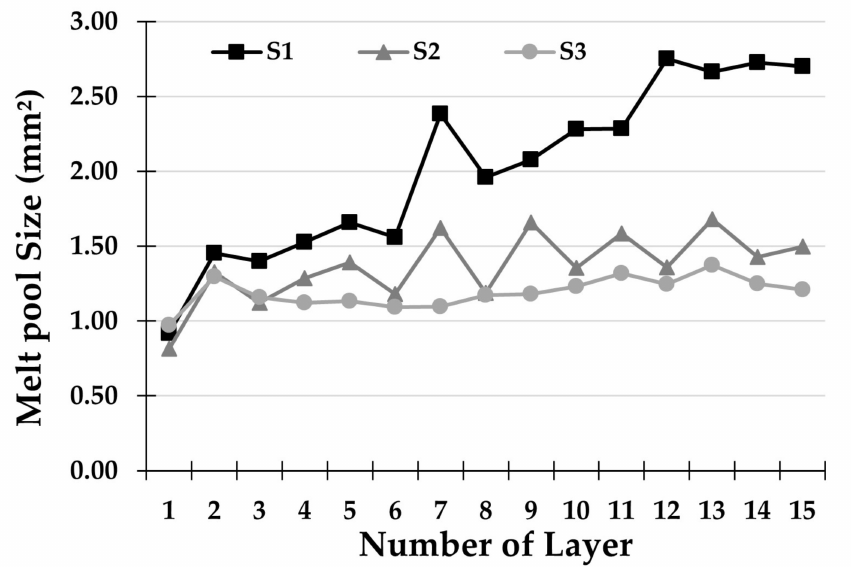
Figure 8. Comparison of melt pool sizes for each deposited layer for the three different